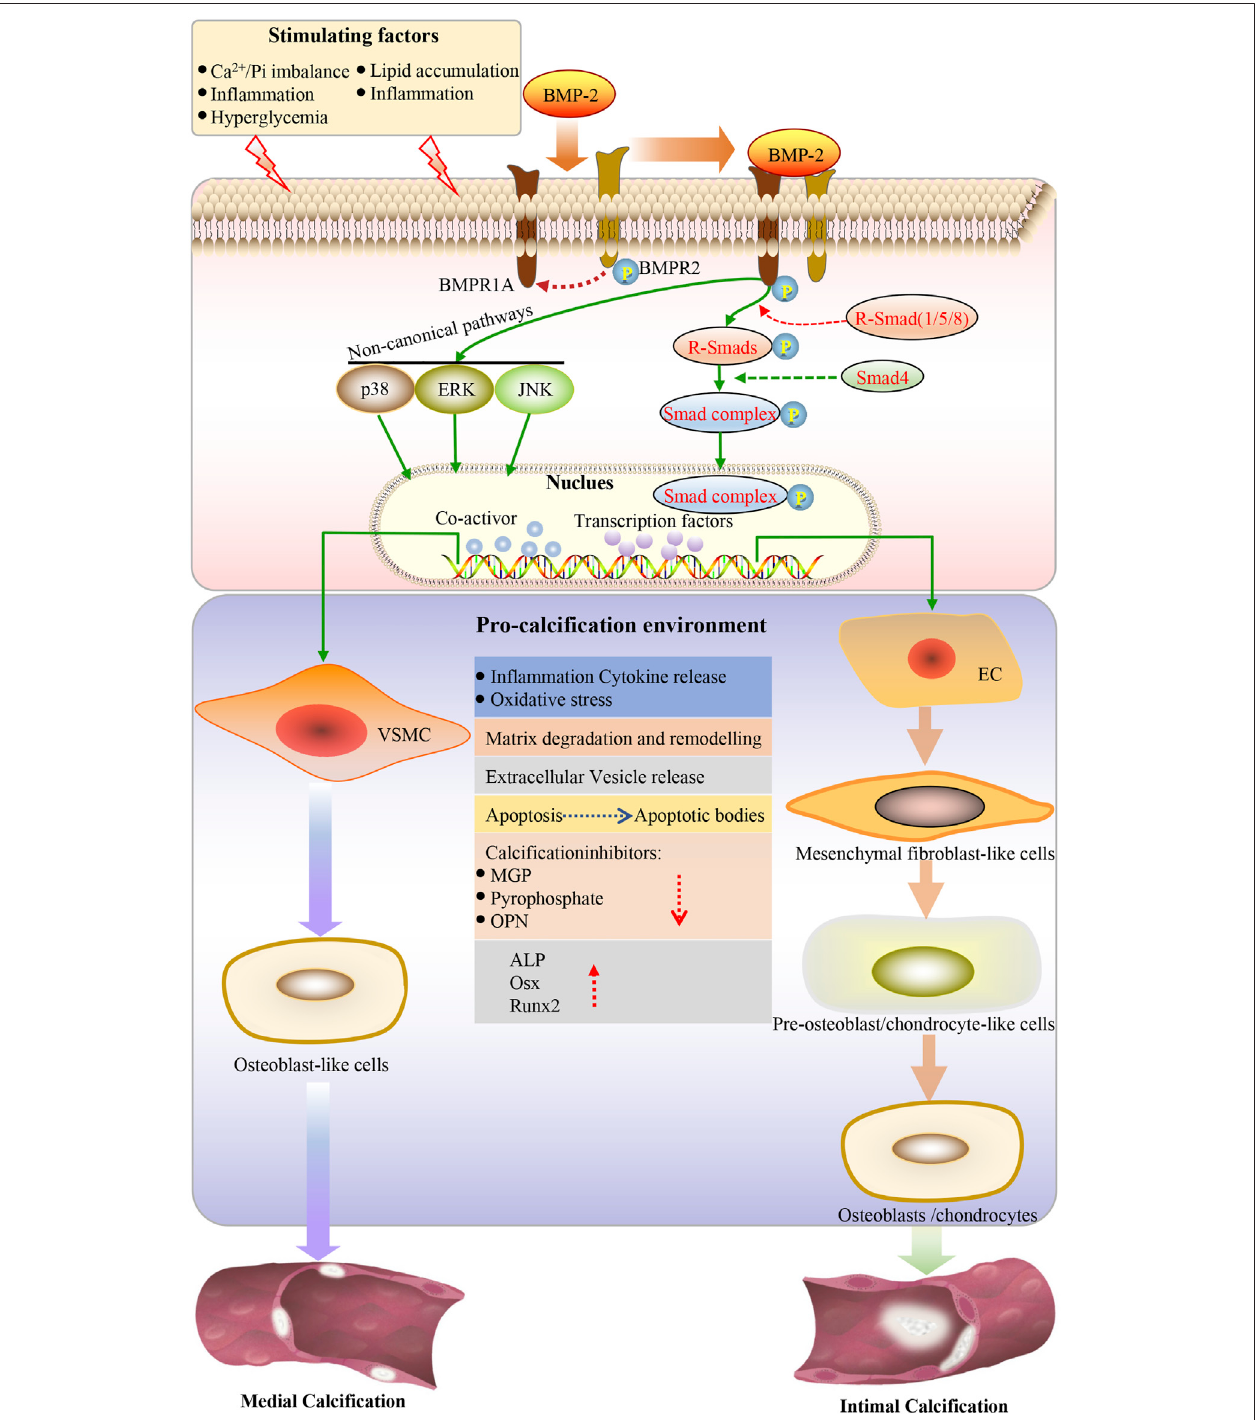
FIGURE 2 | Under the action of stimulating factors, BMP2 binds to the receptor, the type I receptor is phosphorylated by the type II receptor, subsequently activating the classical BMP-SMAD and BMP-noncannonical pathway. SMAD1/5/8 is the effector of the BMP-SMAD pathway. Phosphorylated SMAD1/5/8 forms a heterogeneous complex with SMAD4 and is translocated to the nucleus, where it can regulate the expression of target genes by interacting with other transcription factors. Endothelial cells undergo endothelial mesenchymal transformation and differentiate into mesenchymal fi broblasts, which further differentiate into pre- osteoblasts and osteoblasts in a pro-calci fi ed environment, leading to intimal calci fi cation. VSMCs can be transformed into the bone/cartilage phenotype. Osteogenic/ chondroblast-like cells actively promote calci fi cation by reducing the expression of calci fi cation inhibitors, increasing apoptosis, releasing apoptotic bodies and calci fi ed